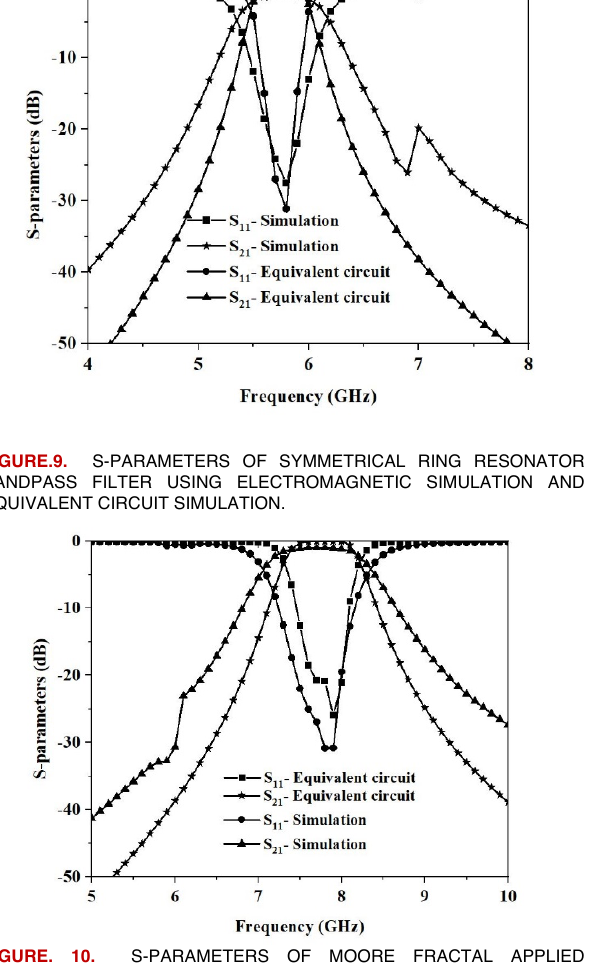
FIGURE. 10. S-PARAMETERS OF MOORE FRACTAL APPLIED SYMMETRICAL RING RESONATOR BANDPASS FILTER USING ELECTROMAGNETIC SIMULATION AND EQUIVALENT CIRCUIT